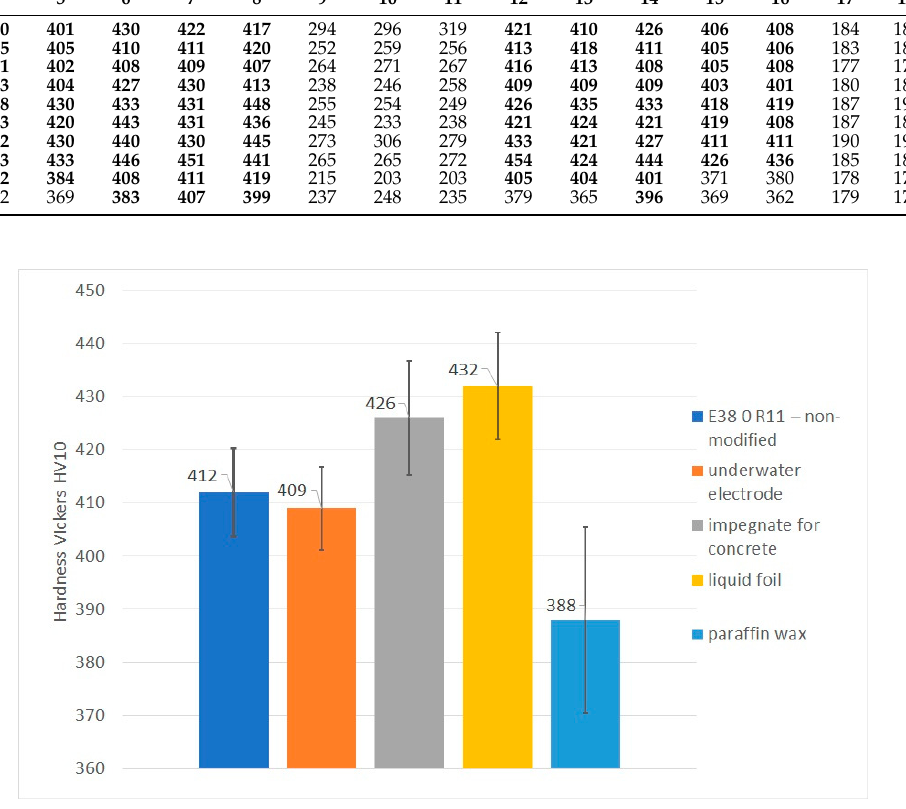
Figure 5. The average HV10 hardness values in the HAZ.